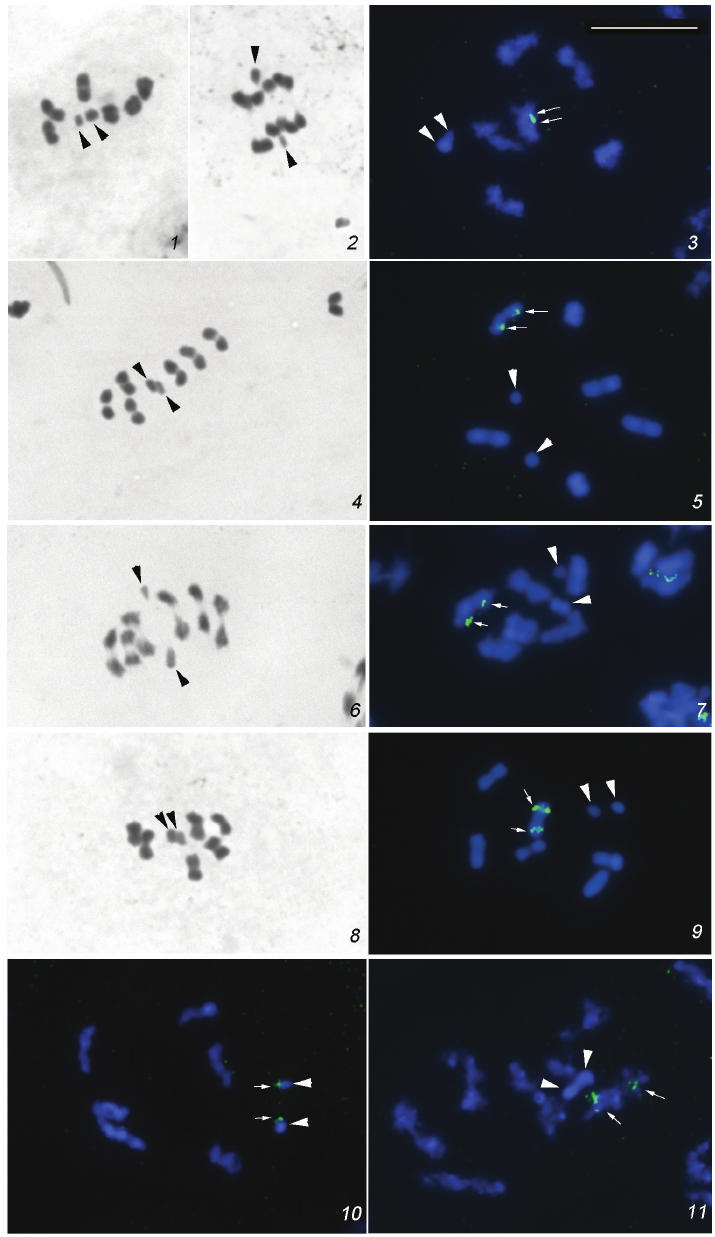
Figures 1–11. Meiotic chromosomes of the Tingidae species with 2n = 12 + XY studied using conven- tional staining technique and 18S rDNA FISH. 1–3 Stephanitis caucasica 1, 2 conventional staining: MI (1), AI (2) 3 FISH: MI 4, 5 Stephanitis pyri 4 conventional staining: MI 5 FISH: MI 6, 7 Physatocheila confinis 6 conventional staining: MI/AI transition 7 FISH: early MI 8, 9 Dictyla rotundata 8 conventional staining: MI 9 FISH: MI 10 Dictyla echii FISH: early MI 11 Lasiacantha capucina FISH: prophase I. rDNA FISH signals are indicated by arrows. X and Y chromosomes are indicated by arrowheads. Bar =